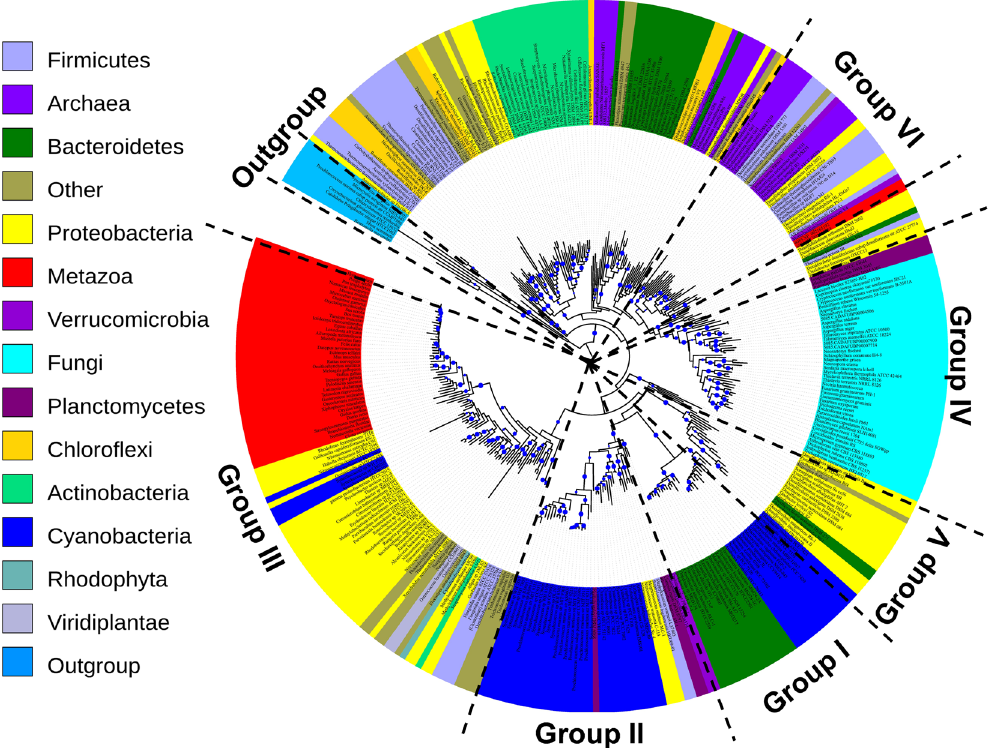
Figure 2. Phylogeny of ArsM As(III) SAM methyltransferases. The phylogenetic tree was constructed using the maximum likelihood program RAxML. The statistical significance of the branch pattern was estimated by conducting 100 bootstrap replications of the original amino acid alignment; bootstraps > 50 were shown as blue circle. The detailed trees of each group are provided in Fig. 3, Figure 4–6 The related SAM-dependent mycolic acid cyclopropane synthetase ( cmaS ) genes were used as outgroup 14